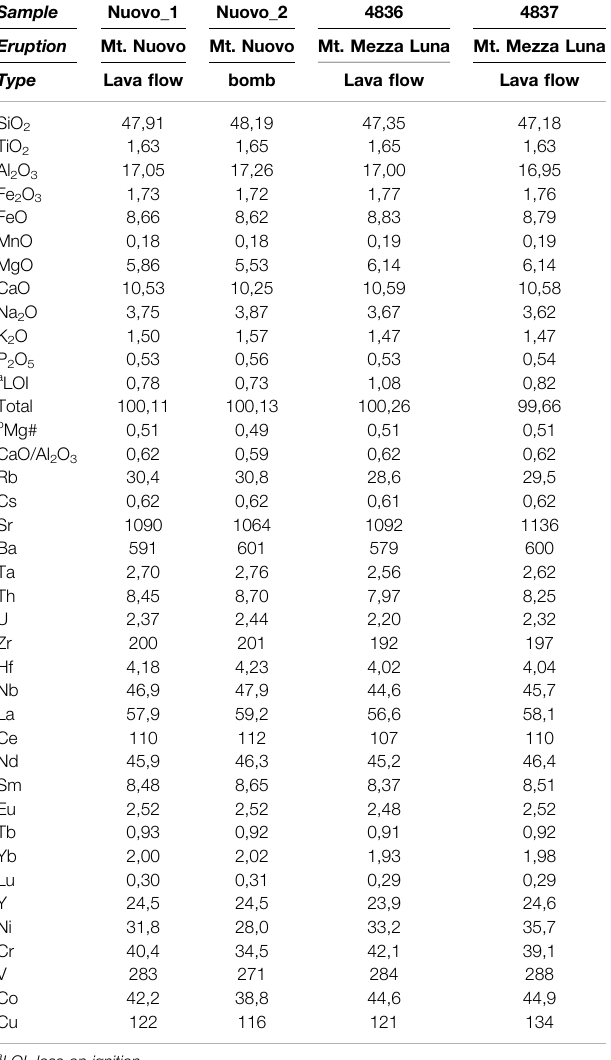
TABLE 1 | Major and trace elements composition of the lavas/pyroclasts erupted during the Mt. Nuovo and Mt. Mezza Luna